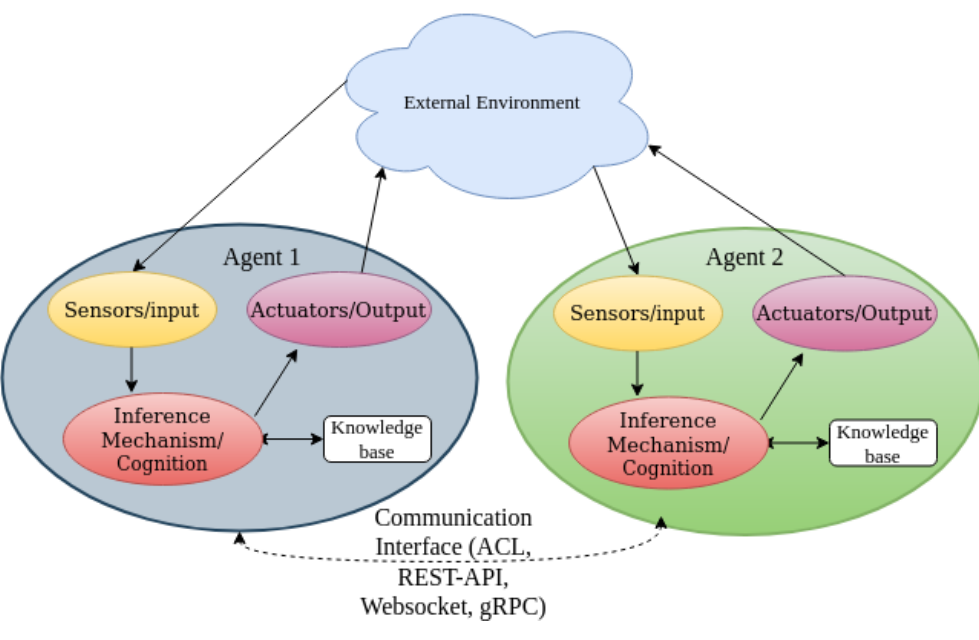
Figure 1. A simple MAS